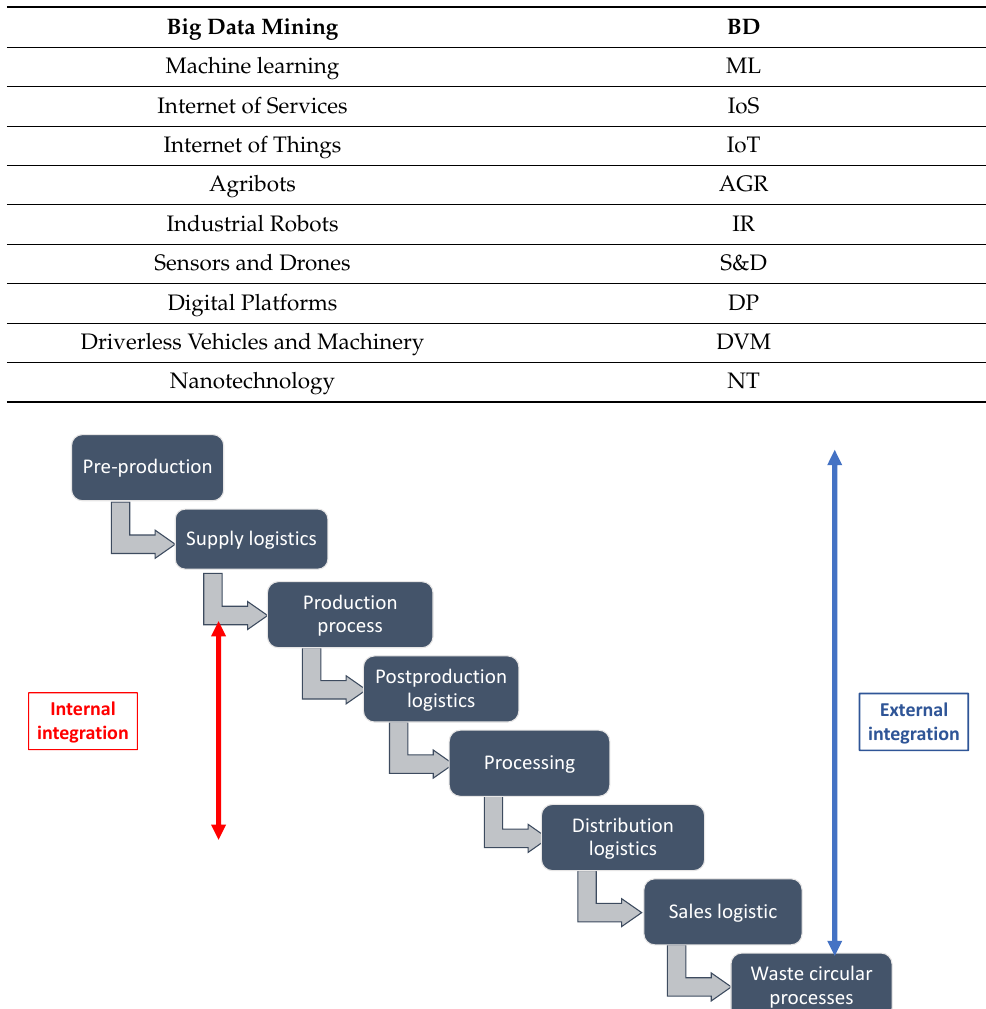
Figure 2. AI vertical integration of food value and supply chain (own).